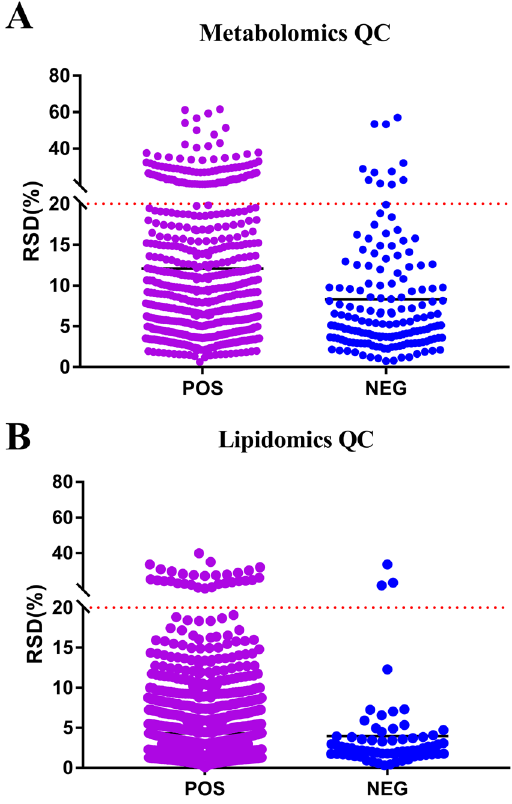
Figure 3. The RSD values of the peak intensities in QC samples. ( A ) Scatter plot of RSD values in metabolomics QC samples ( B ) Scatter plot of RSD values in lipidomics QC